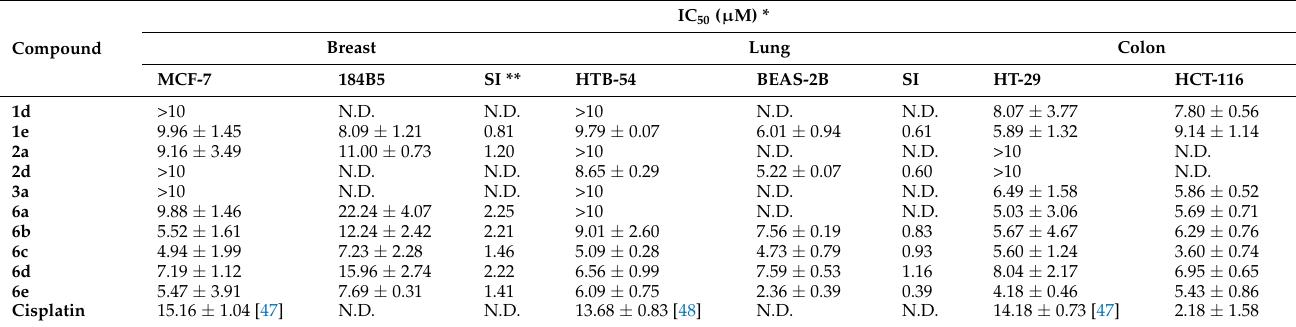
Table 1. Cytotoxic activity expressed as average IC 50 values ( µ M) and selectivity indexes (SI) calculated for selected selenoureas. Cisplatin was taken as reference compound.